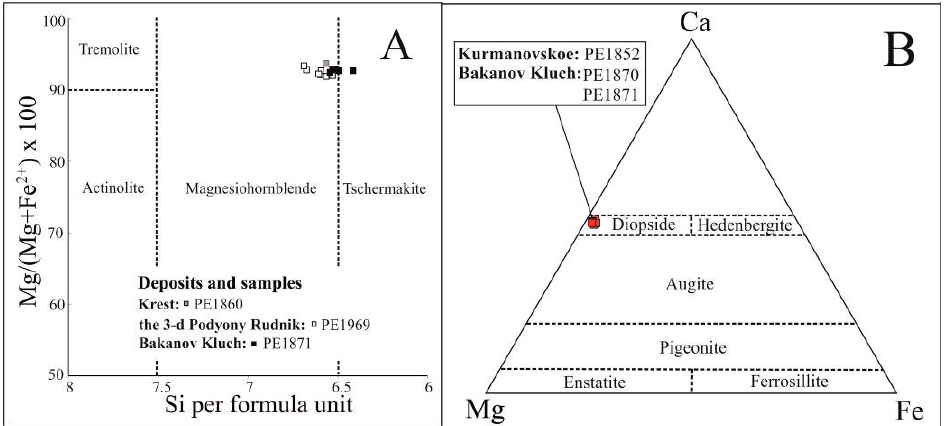
Figure 14. Compositional variations of silicates included in chromite from the Alapaevskychromitites. Binary diagram for the classification of the amphibole ( A ); ternary diagram for the classification of the pyroxenes ( B ). Simplified after [29].